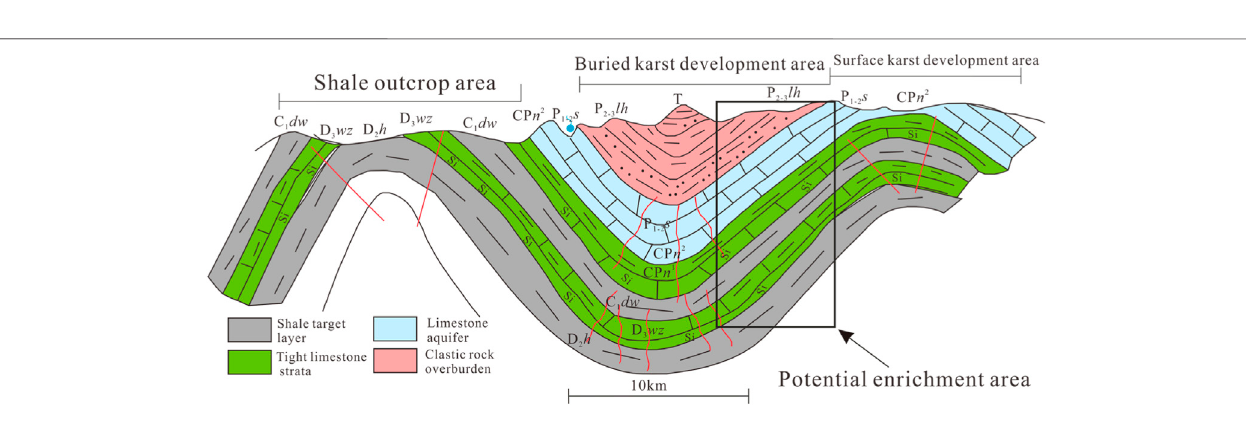
FIGURE 12 | Carbonate controlled shale accumulation model under complex tectonic background in the Qiannan area.